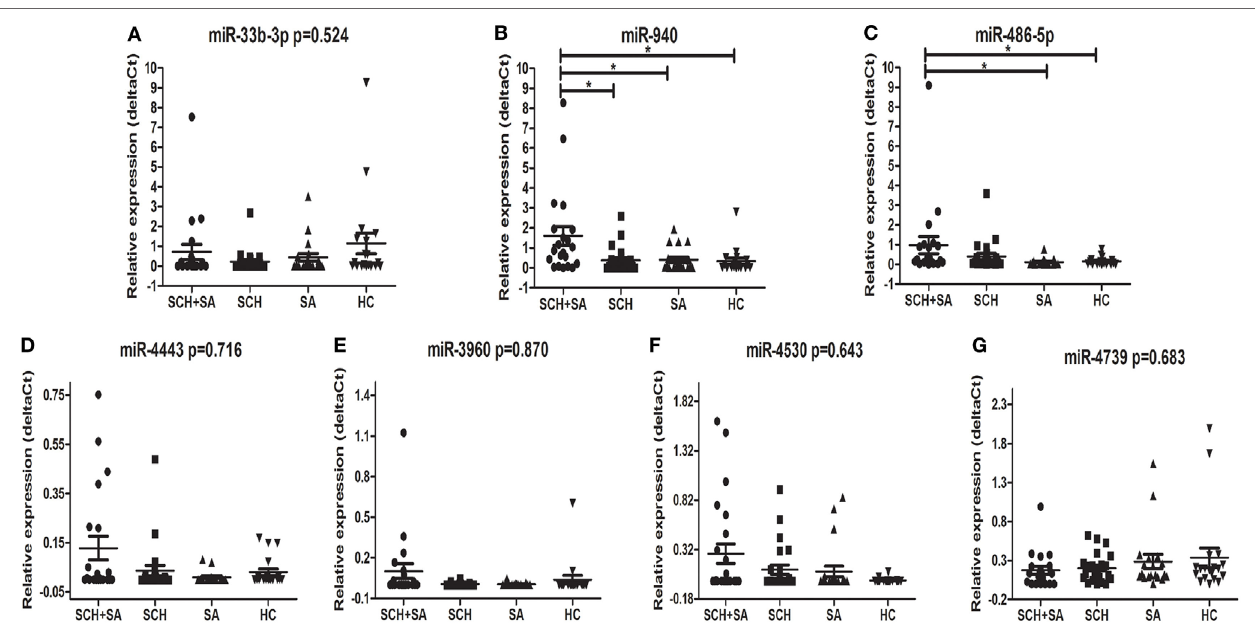
FigUre 2 | Comparison of the serum levels of miR-33b-3p (a) , miR-940 (B) , miR-486-5p (c) , miR-4443 (D) , miR-3960 (e) , miR-4530 (F) , and miR-4739 (g) in subclinical hypothyroidism (SCH) + spontaneous abortion (SA), SCH, SA, and healthy control (HC) groups. Syn-cel-miR-39 served as the spike-in control to monitor the effectiveness of real-time (RT)-polymerase chain reaction (PCR) and quantitative (q)PCR. The serum levels were determined using RT-PCR following RNA extraction. A Kruskal–Wallis test was performed to determine the significance of differences between groups; * p < 0.05 was considered significant.